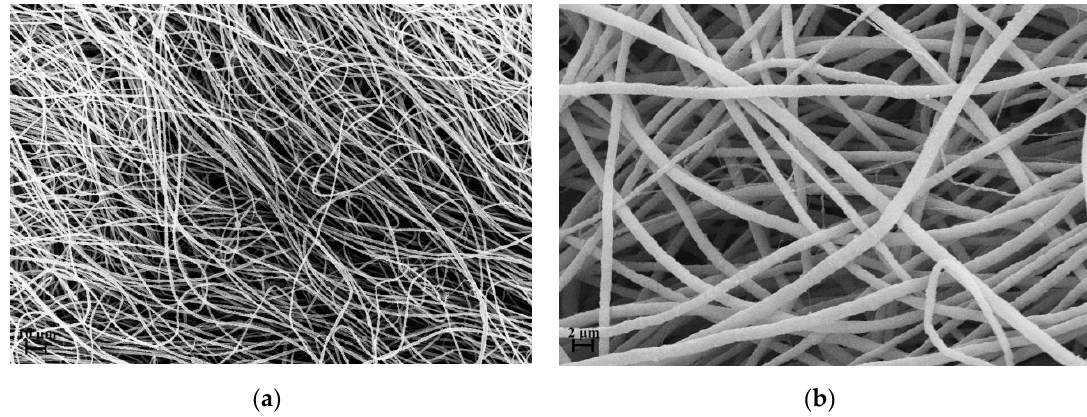
Figure 5. ( a , b ) SEM micrographs of not heat treated mat (PVP_SiO 2 NT) at different magnifications.